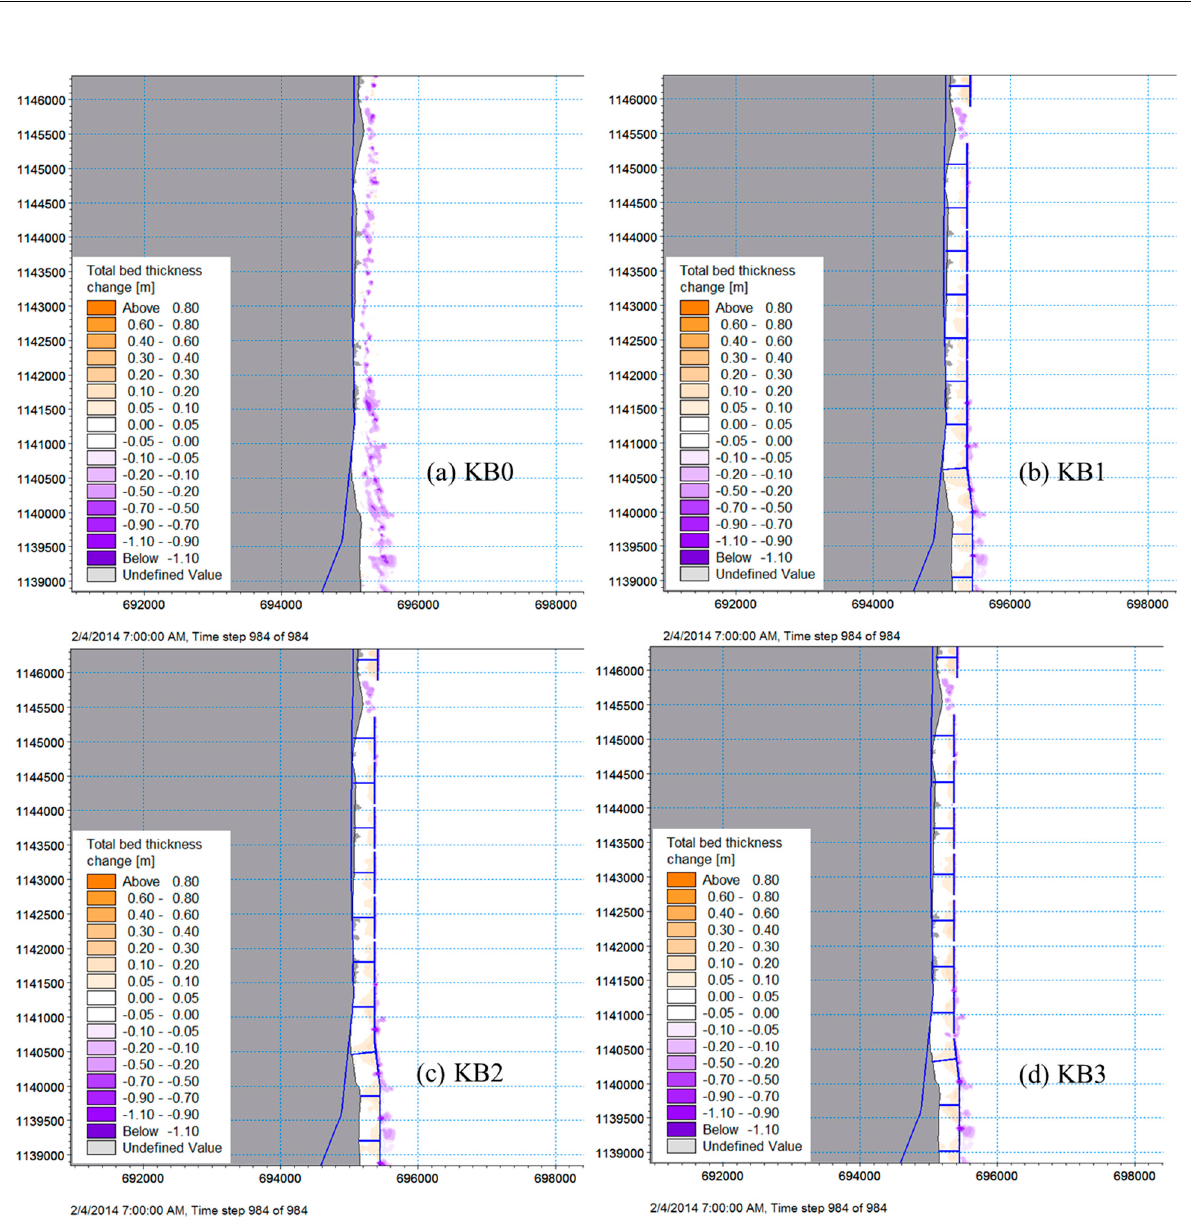
Figure 15. Morphological changes after one month in the NE monsoon (Jan 2014) by MIKE21.